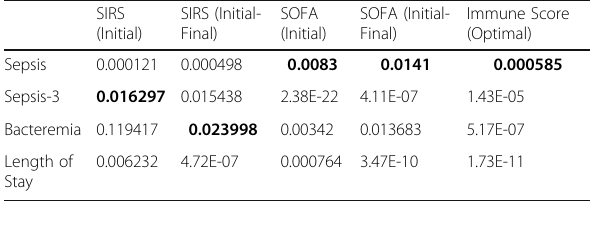
Table 5 (abstract P42). See text for